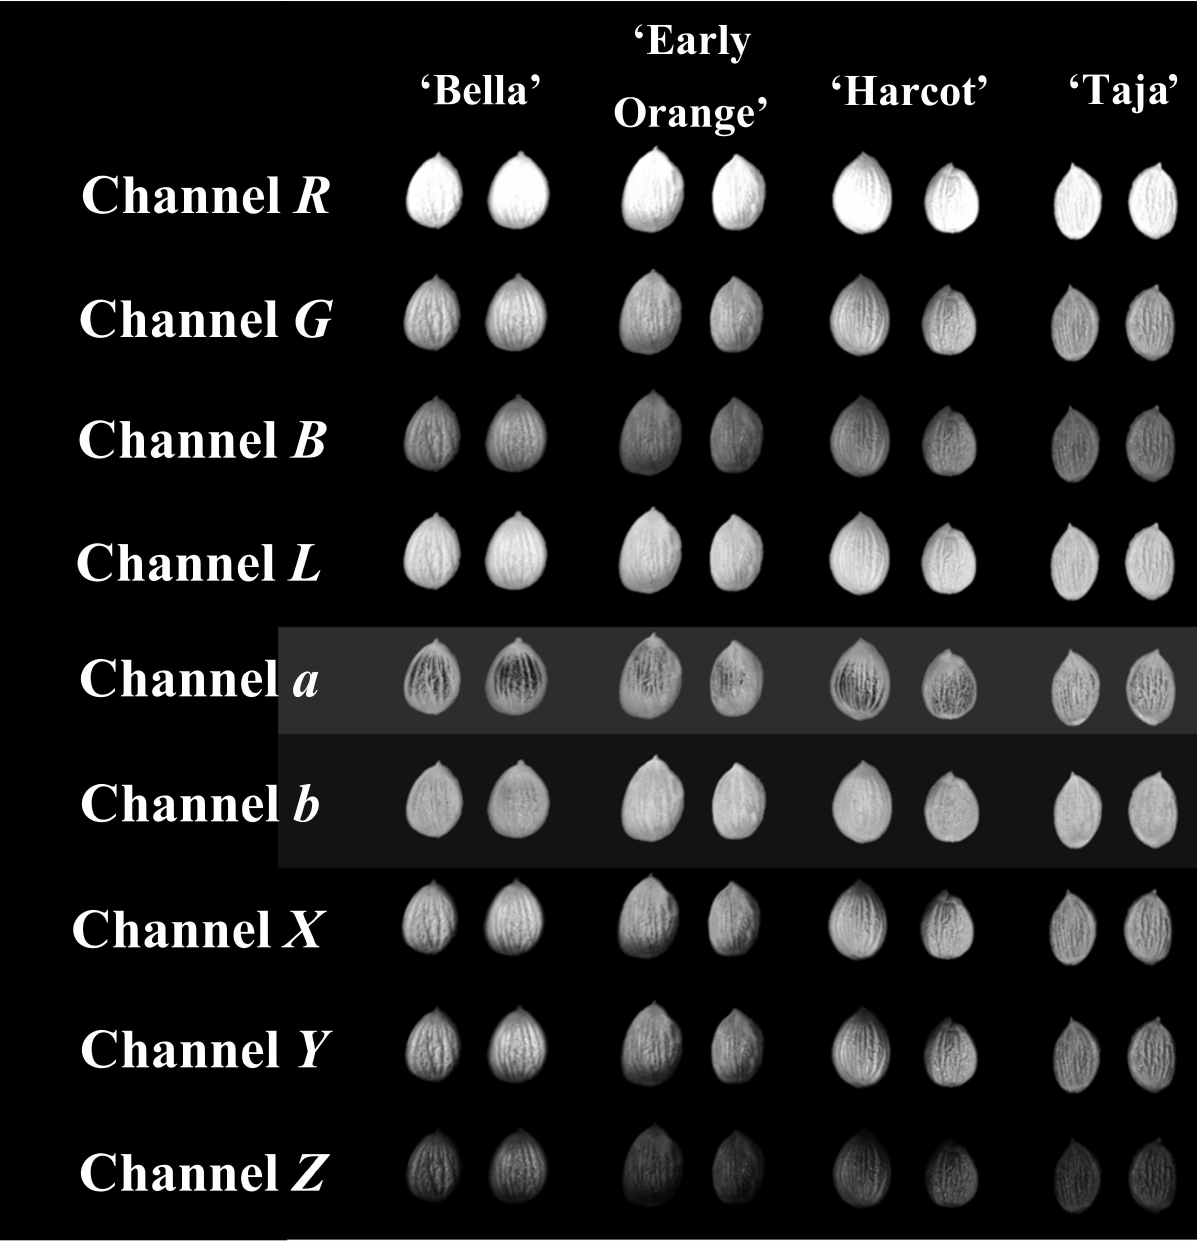
Figure 2. Images of apricot seeds from different color